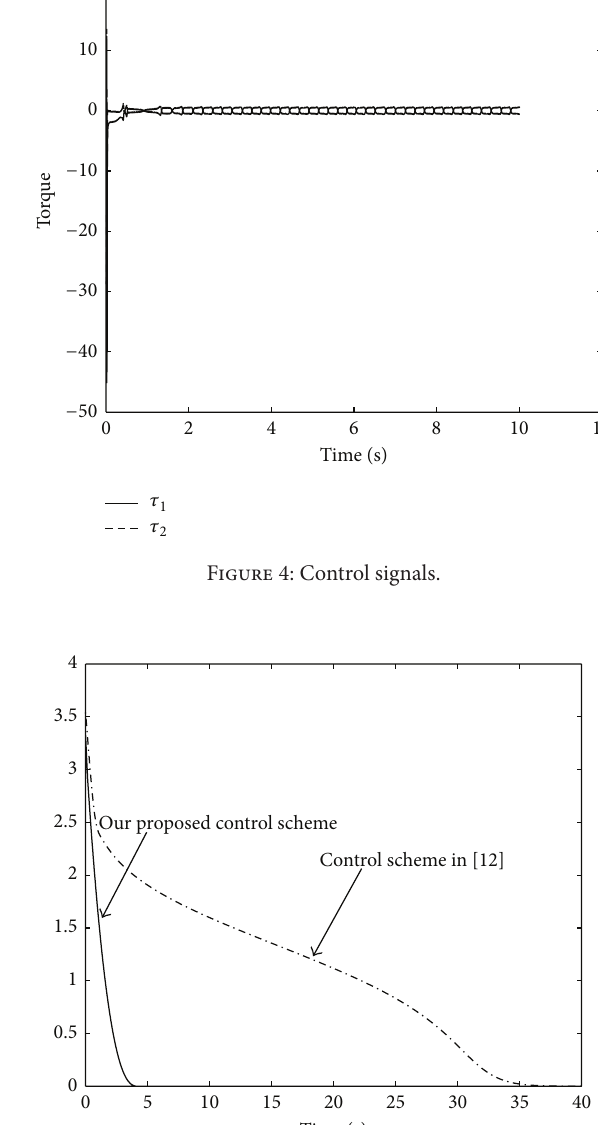
Figure 5: Comparison of our proposed control scheme with the scheme in [12].